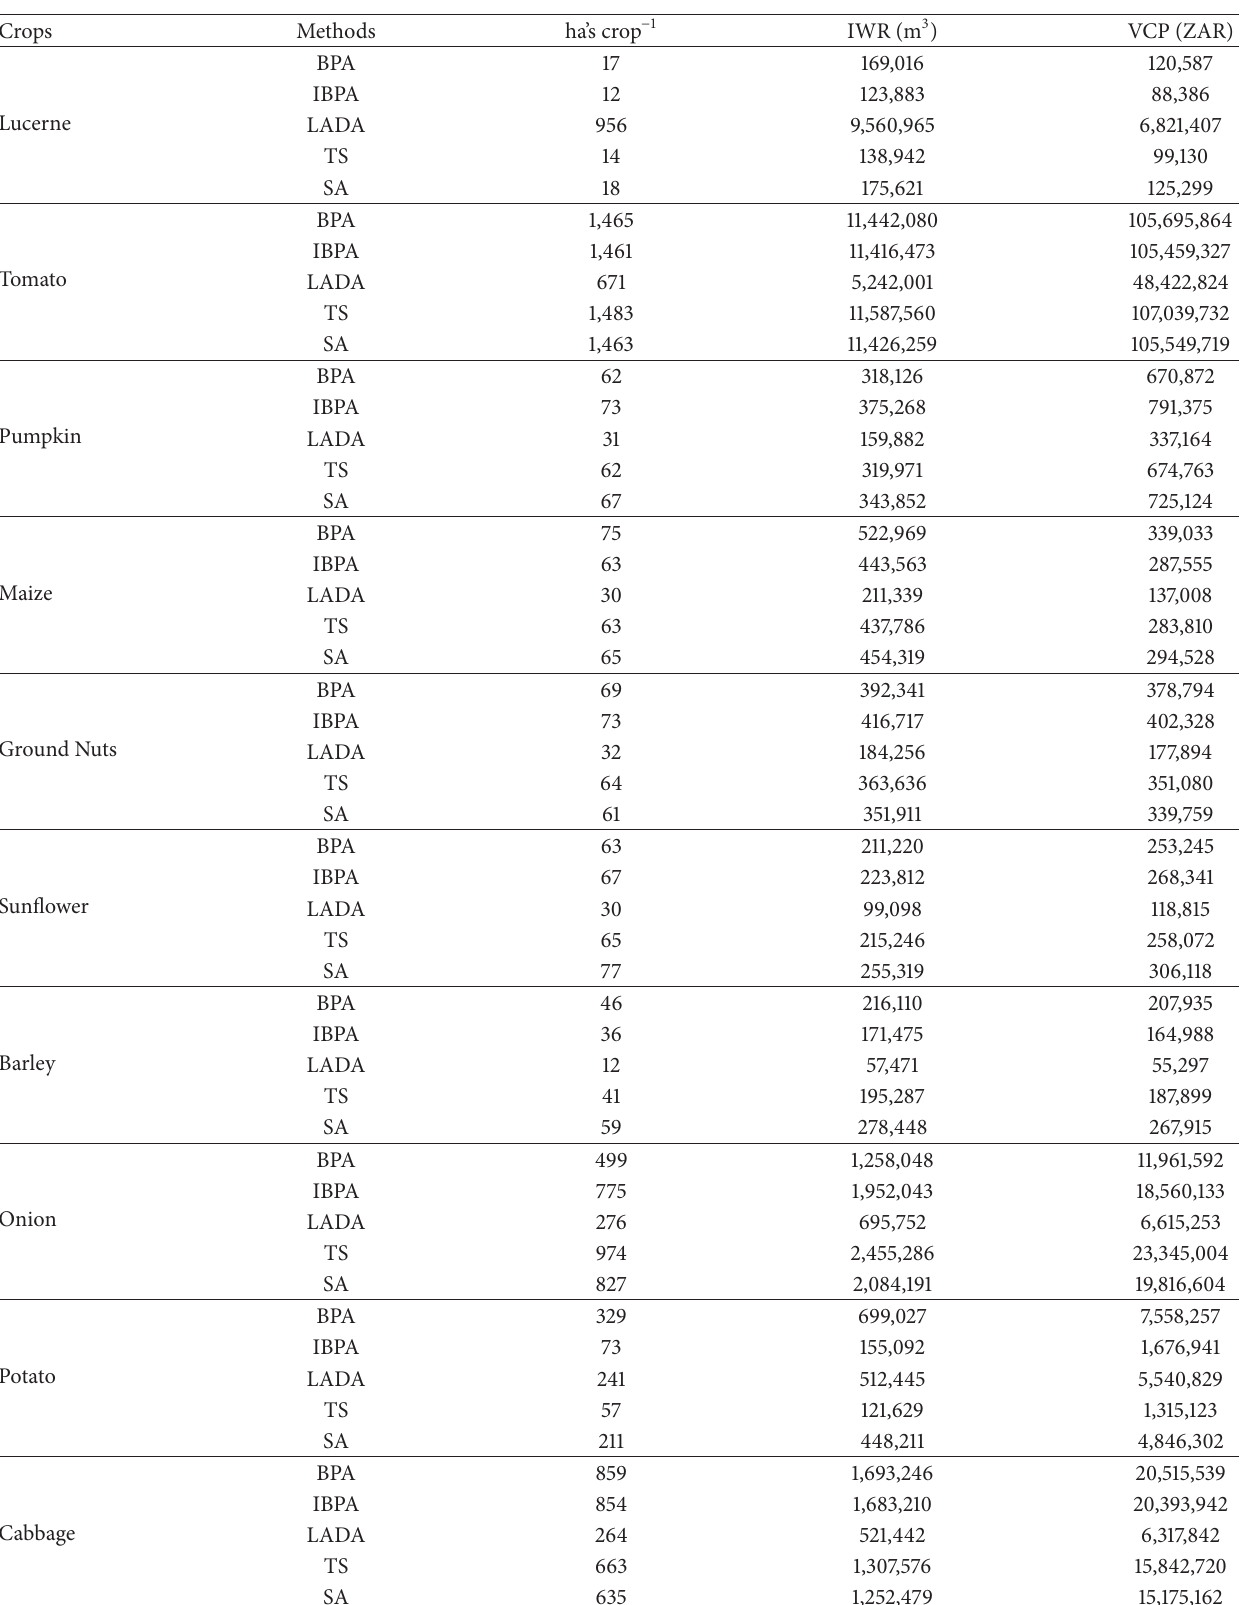
Table 8: Crop statistics of the best solution determined by each heuristic